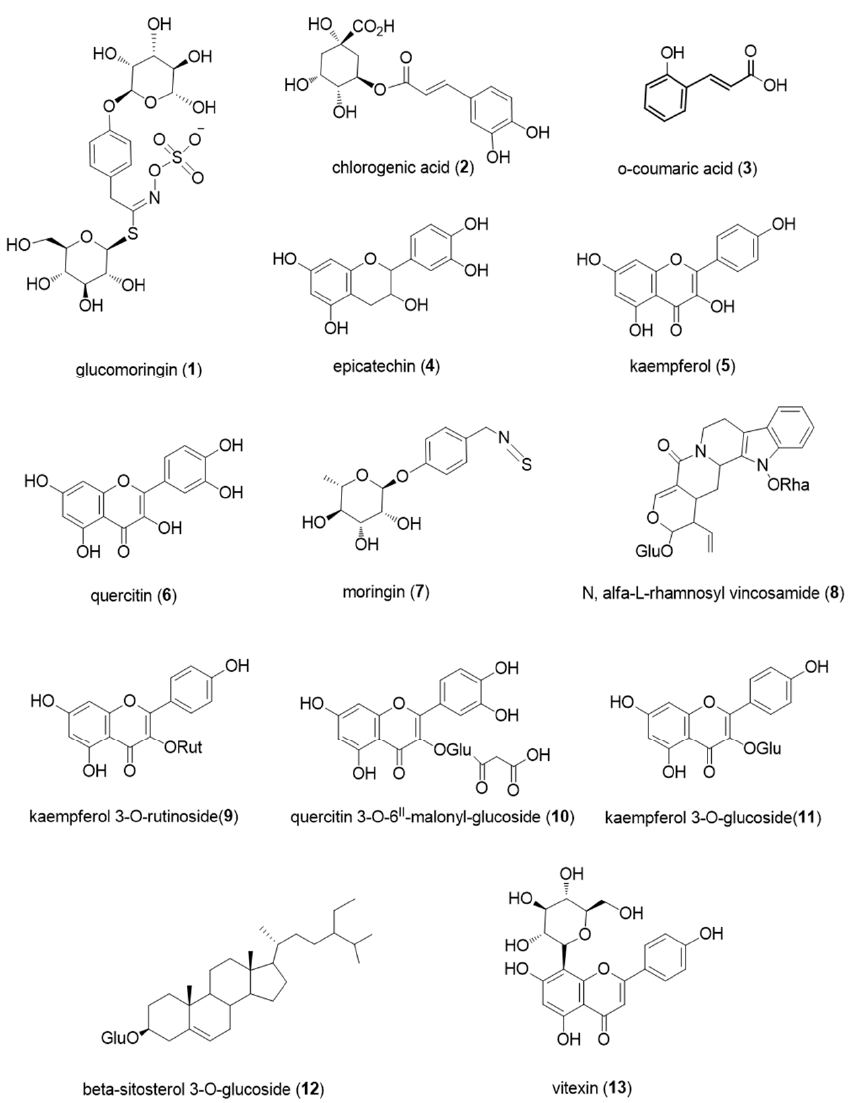
Figure 2. Bioactive metabolites isolated from M. oleifera .